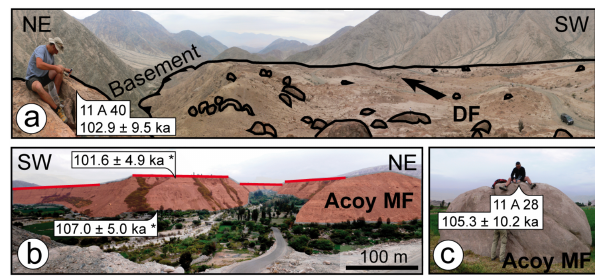
Figure 4. Field photographs showing the debris-flow deposit mor- phology and the Acoy megafan. (a) Characteristic block sampled on the debris-flow deposit. The arrow indicates flowing direction of the debris flow. (b) General view of the Acoy megafan (Acoy MF); red lines highlight the top of the terrace. The OSL ages obtained by Steffen et al. (2010) for the Acoy megafan are indicated with an asterisk. (c) Block sampled on the